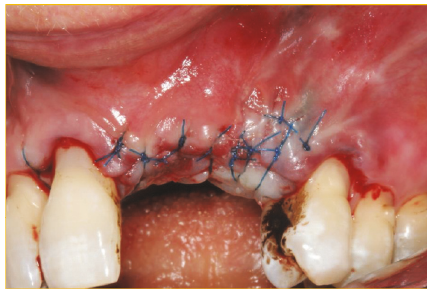
Figure 13: The “labial glove” has been replaced and secured with interrupted 5.0 PROLENE sutures.